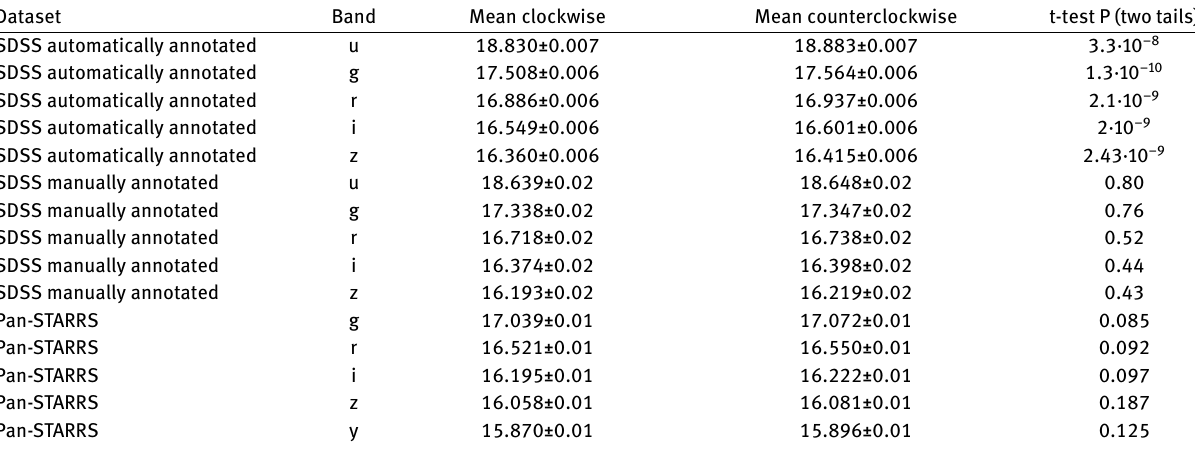
Table 8. Exponential magnitude mean, standard error, and t-test of the difference between clockwise and counterclockwise galaxies in the region of (< 30 ∘ ∨ > 300 ∘